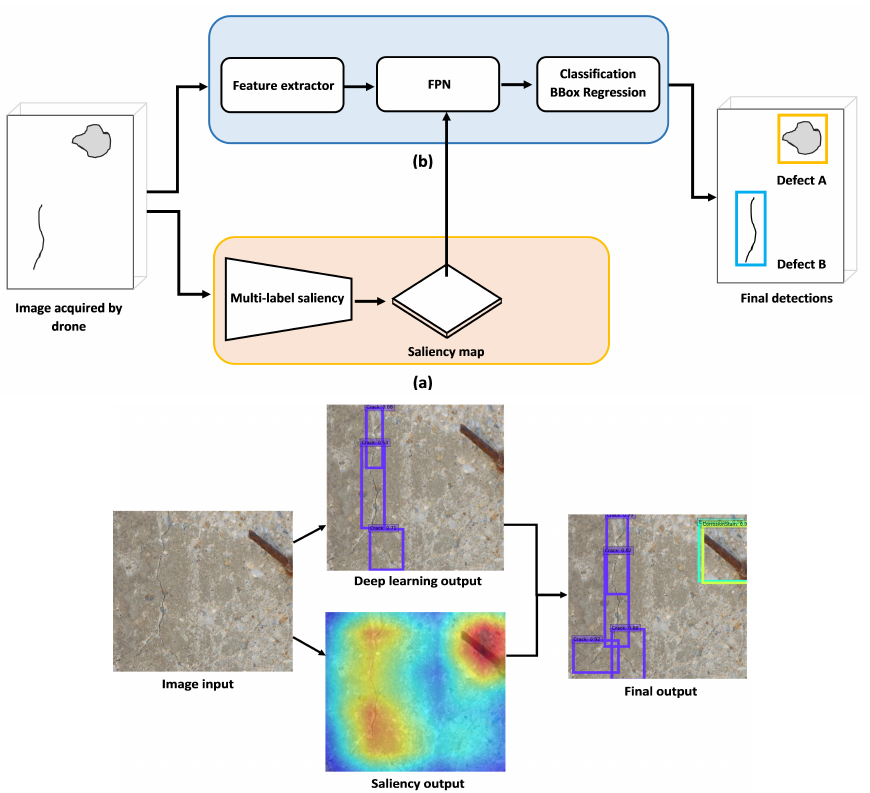
Figure 1. Pipeline of the proposed SMDD-Net method. On the top: ( a ) Saliency computation for the attention module; ( b ) multi-label one-stage concrete defect detection module. On the bottom: An example of our method depicting the benefits of using